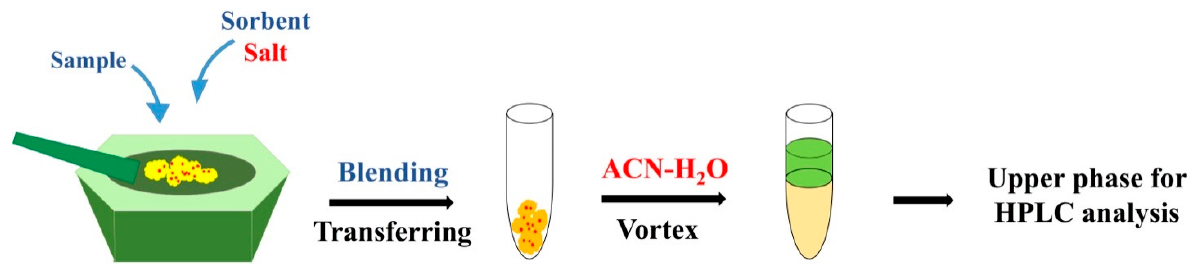
Figure 1. Schematic presentation of micro salting-out assisted matrix solid-phase dispersion ( μ -SOA-MSPD).